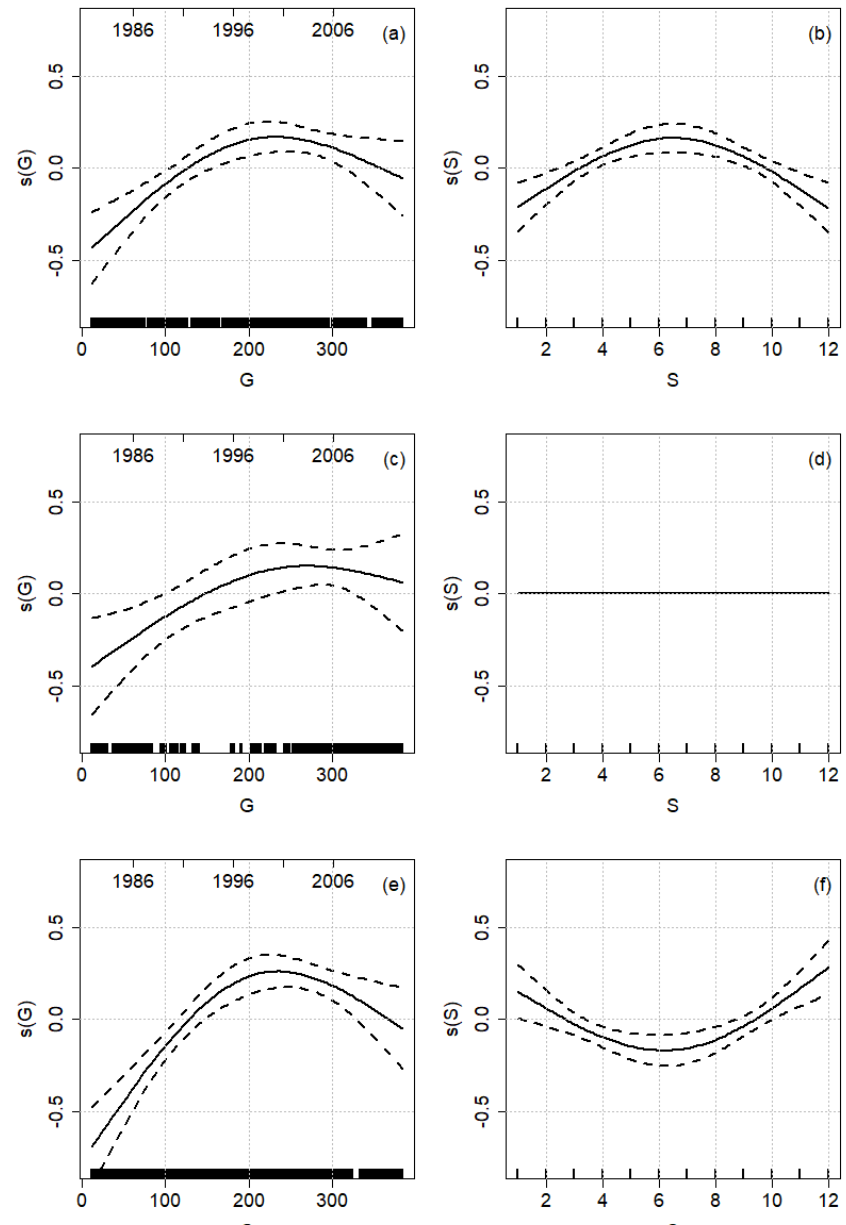
Figure 6. ( a , c , e ) Global ( G ) and ( b , d , f ) seasonal ( S ) terms (continuous black line) and standard error bounds (dashed line) for S1 models ( TRR = l ( G ) + s ( S )